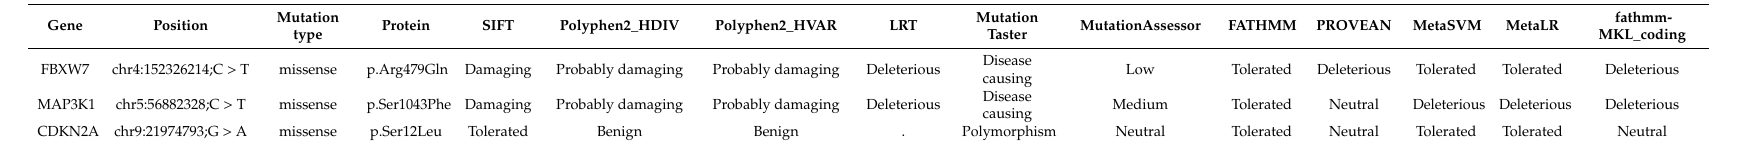
Table 2. Summary of the validated mutations in silico